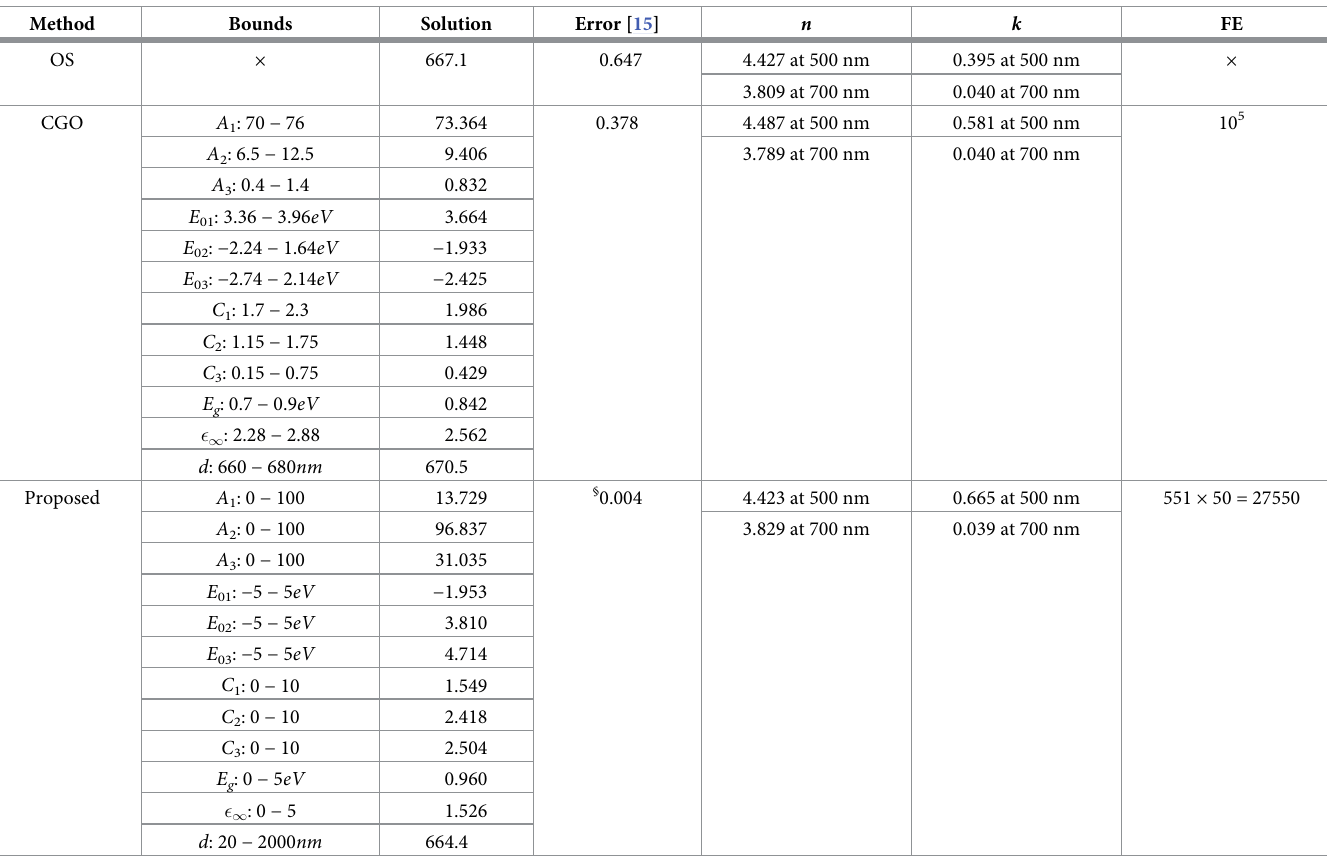
Table 6. Performance comparison between the proposed method and the existing methods based on OptiChar software and CGO algorithm. Here, the estimation error is defined according to the reference [15]. Note that the § error is calculated with reference to the spectral data [15] generated using a plot digitizer [48], while consid- ering 651 points in the wavelength range of 400 − 900 nm .